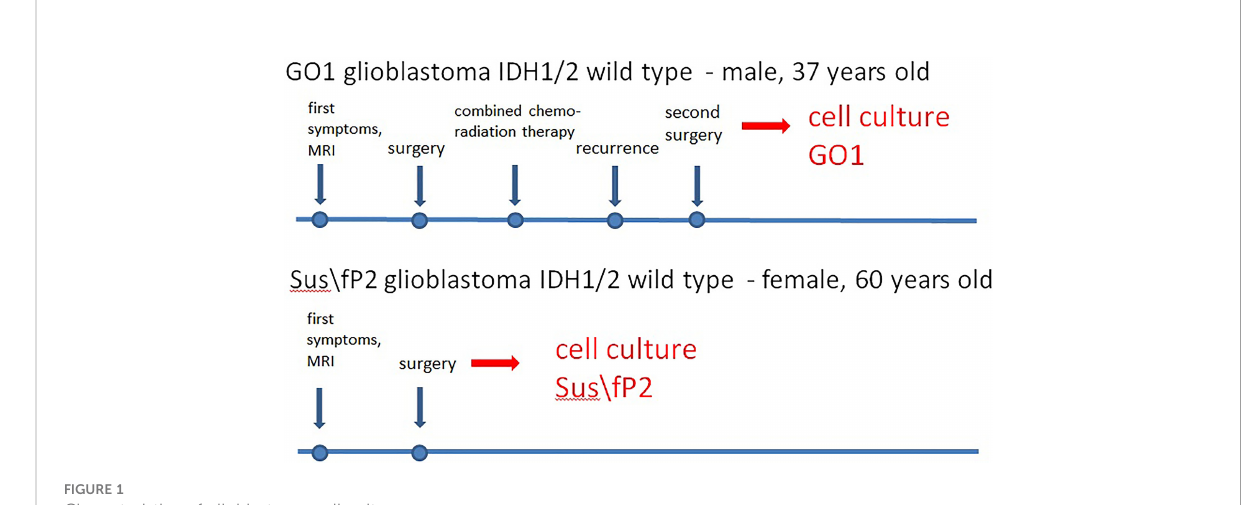
FIGURE 1 Characteristics of glioblastoma cell